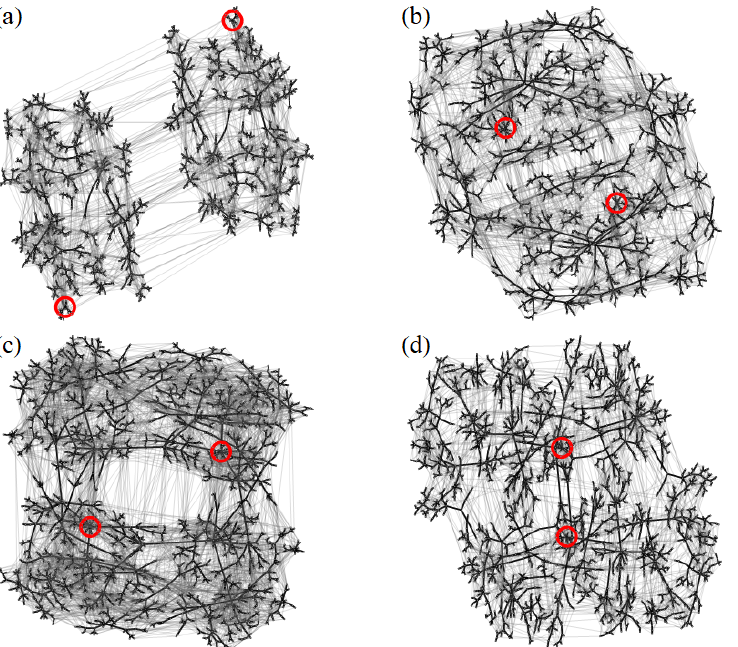
Figure 6. Kinetic networks of the local minima and transition states of the strongly-disordered ensembles ( a – d ) illustrated in Figure 5. The two-fold degenerate ground states are indicated by red circles. The highlighted black segments indicate the transitions, which connect each minimum with a minimum having a lower or equal energy by involving the smallest energy barrier. The number of local minima and transition states of each NP ensemble may be found Table 3.